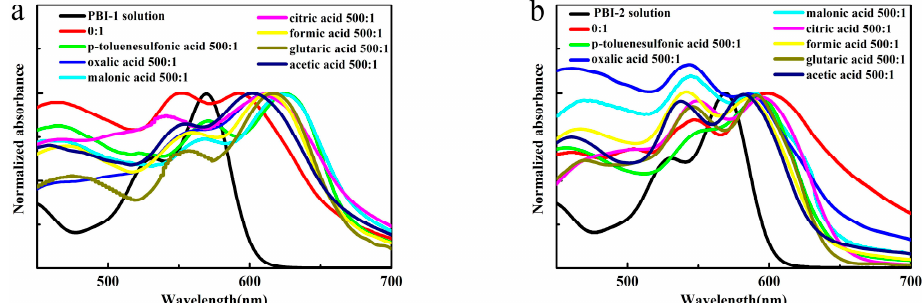
Figure 2. Normalized UV–visible (UV–vis) absorption spectra of PBI-R solution and PBI-R aggregates assembled in various organic acids. ( a ) PBI-1 and ( b ) PBI-2.